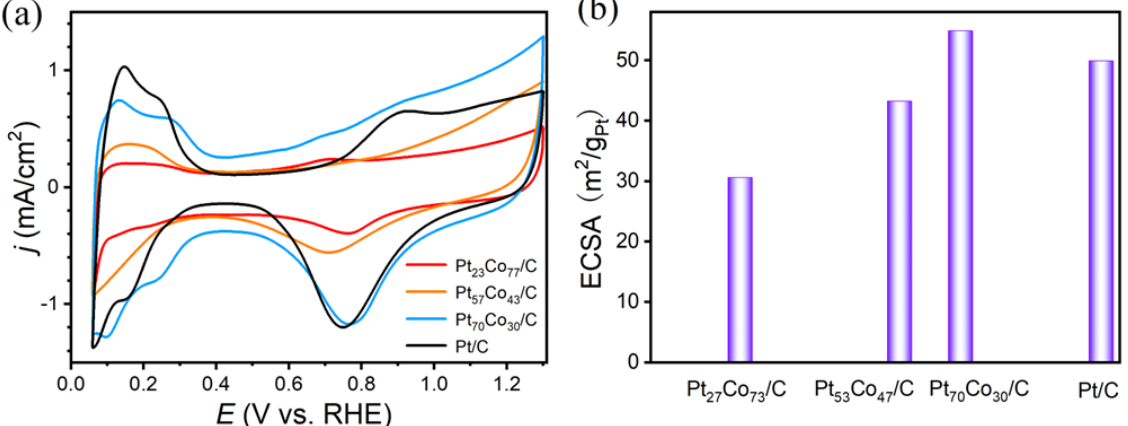
Figure 4. CV curves ( a ) with the corresponding ECSA ( b ) of Pt 27 Co 73 /C, Pt 53 Co 47 /C, Pt 70 Co 30 /C and commercial Pt/C in 0.1 M HClO 4 solution. Table 1. Comparison of MOR activities of various catalysts.